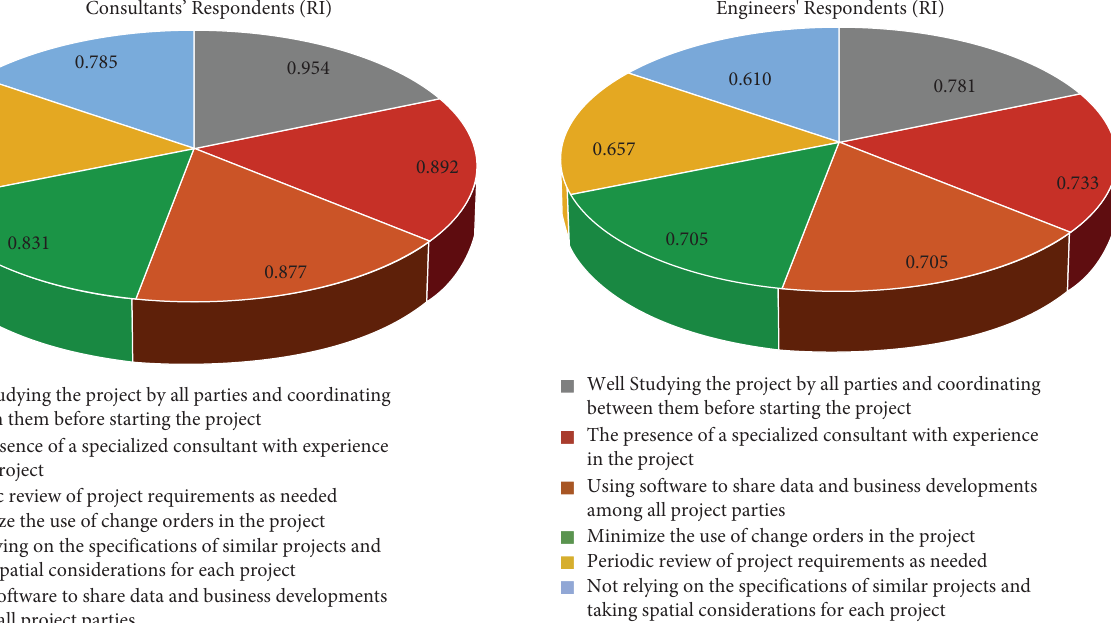
Figure 7: )e most important factors that mitigate the impacts of change orders (engineers’ responses).